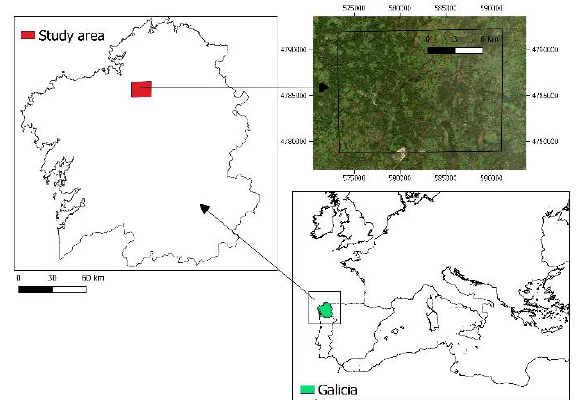
Figure 1. Study area. Reference image PNOA (National Aerial Orthophotography Plan, for its initials in Spanish) image (IGNb, 2021).